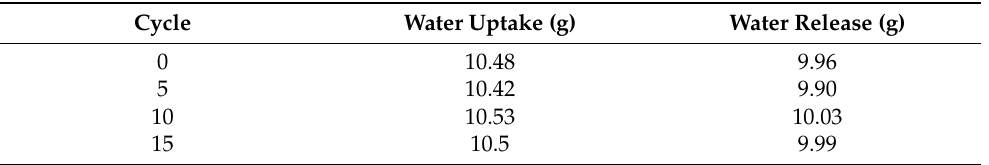
Figure 11. Water collection of PAN/AM/graphene/CaCl 2 for different water collection cycles (with magnifying glass). Table 1. Water collection of PAN/AM/MWCNTs/CaCl 2 for different water collection cycles (with magnifying glass).